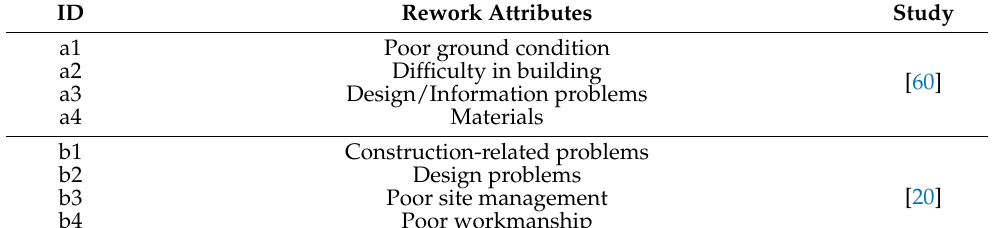
Table 1. Bulk information for rework attributes [59] .